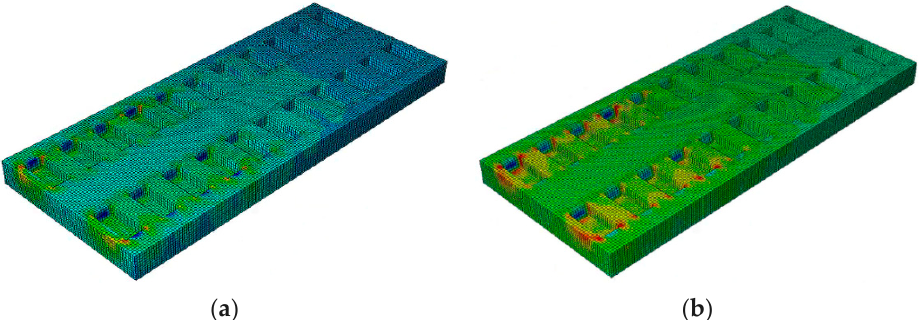
Figure 30. Stress cloud diagram of track bed slab under lateral and vertical coupled load. ( a ) TLVT track slab. ( b ) ILVT track slab.